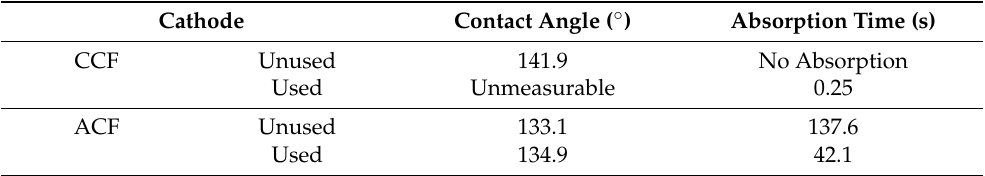
Table 1. Contact angle and absorption time of each cathode current collector (CCC) before and after charge/discharge cycles, where unmeasurable means that the drop was too rapidly absorbed.